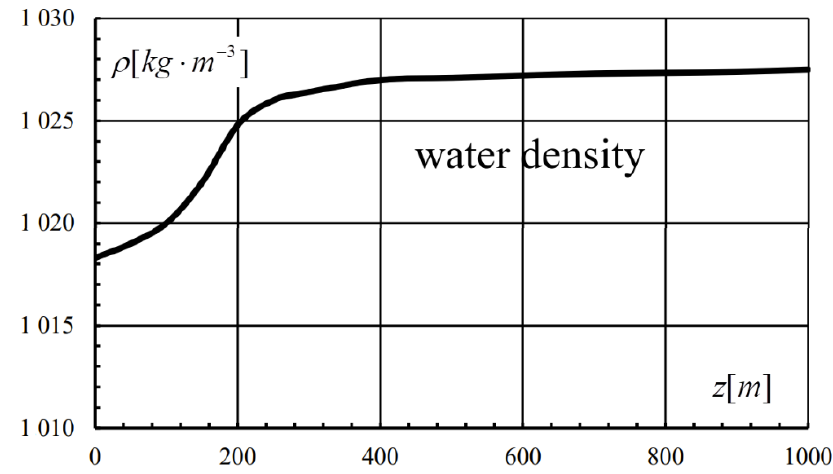
Figure 15. Typical depth-wise density distribution in equatorial waters.